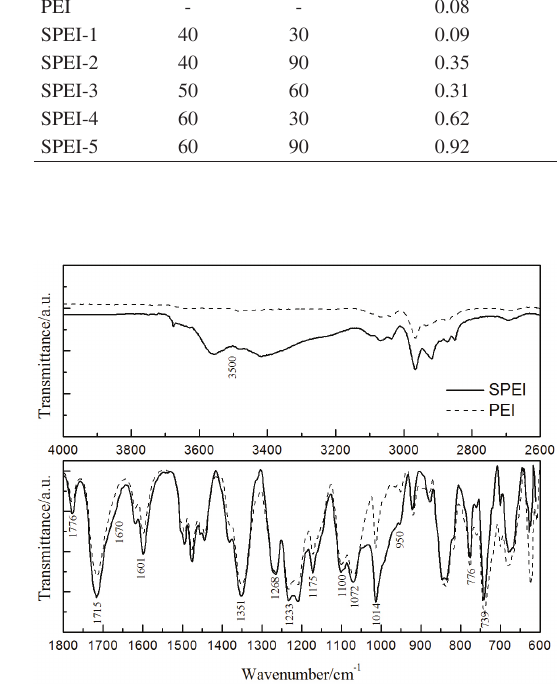
Figure 1. PEI (dashed line) and SPEI (solid line) FTIR spectra.